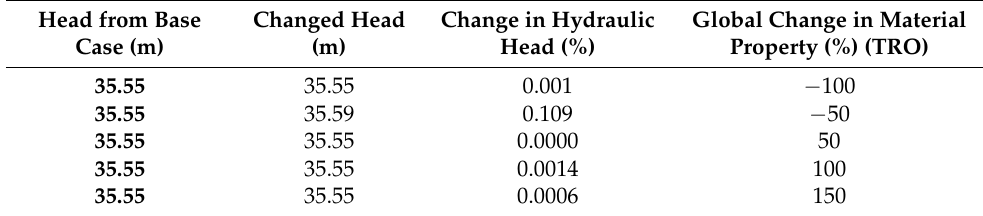
Table 3. Variation of hydraulic head with changed material property (transfer rate out).